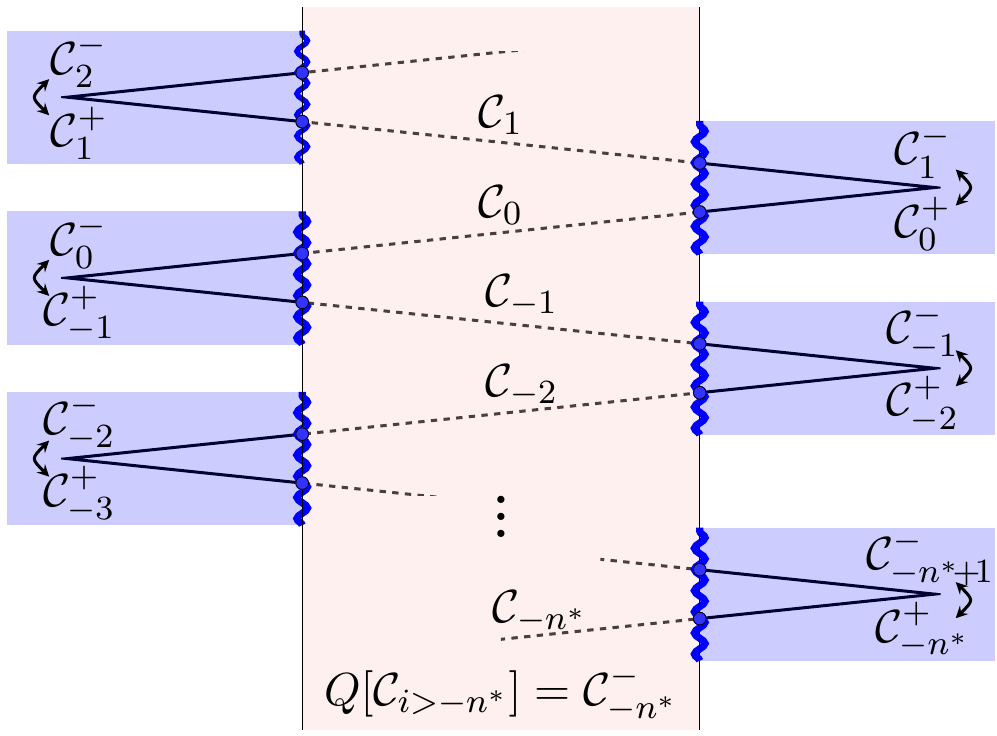
Figure 1 . The duality chain. Each straight line under C i corresponds to the phase diagram of the theories under the common mass deformations of the matter (cid:12)elds. Blue regions are the semiclassical phases C (cid:6) obtained from the integrating out fermions with large positive/negative mass and are i shared by asymptotic phase of adjacent theories. Each blue wavy line corresponds to the critical line with same universality class. As we go down the duality chain, quantum phase of C 0 which denoted as Q [ C 0 ] is determined by semiclassical phase of the C (cid:0) n (cid:3) within (cid:12)nite steps. Together with going up the duality chain, intermediate quantum phase is shared by in(cid:12)nitely many UV theories C i with i > (cid:0) n (cid:3)